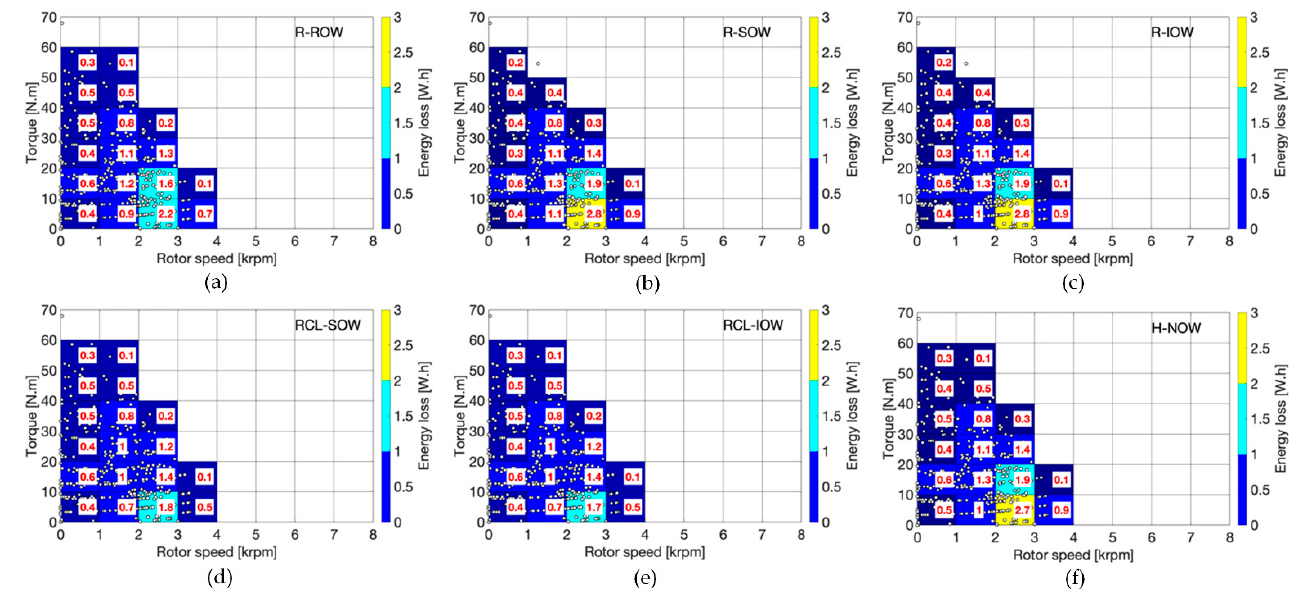
Figure 12. Energy loss distributions of the IPMSM with ( a ) R-ROW, ( b ) R-SOW, ( c ) R-IOW, ( d ) RCL-SOW, ( e ) RCL-IOW, and ( f ) H-NOW arrangements, along the ARTEMIS urban driving cycle.